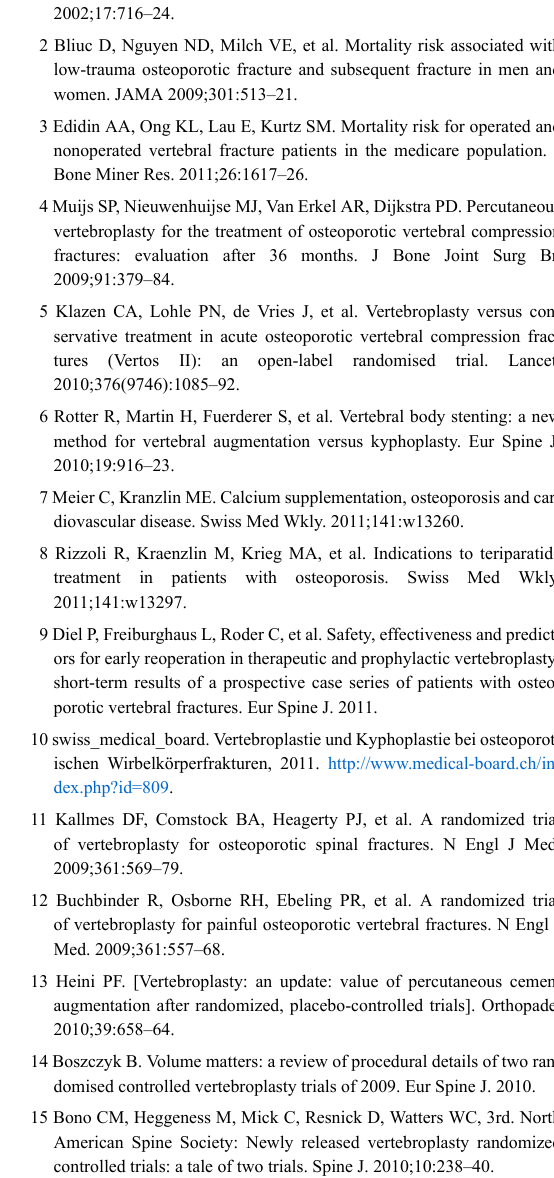
Case report stentoplasty: This 77-year-old male patient is referred to the emergency room after a fall from some 1.5 m. He presents with acute immobilising back pain. The x-ray taken in the supine position depicts fractures of T12 and L1 (a). The MRI scan discloses a fresh fracture of L1, whereas T12 appears old (b). The fracture was considered simple and conservative treatment was initiated with in- hospital physiotherapy and pain medication. After 3 days a standing X-ray was performed which shows a much more complex lesion in comparison to the initial pictures (white arrows): There is a split fracture with anterior wall displacement, and also the upper endplate has subsided considerably (c). A stentoplasty procedure was performed in local anesthesia, which did provide good height restoration and immediate stabilisation (d). The intraoperative pictures demonstrate complete restoration of the vertebral body’s shape